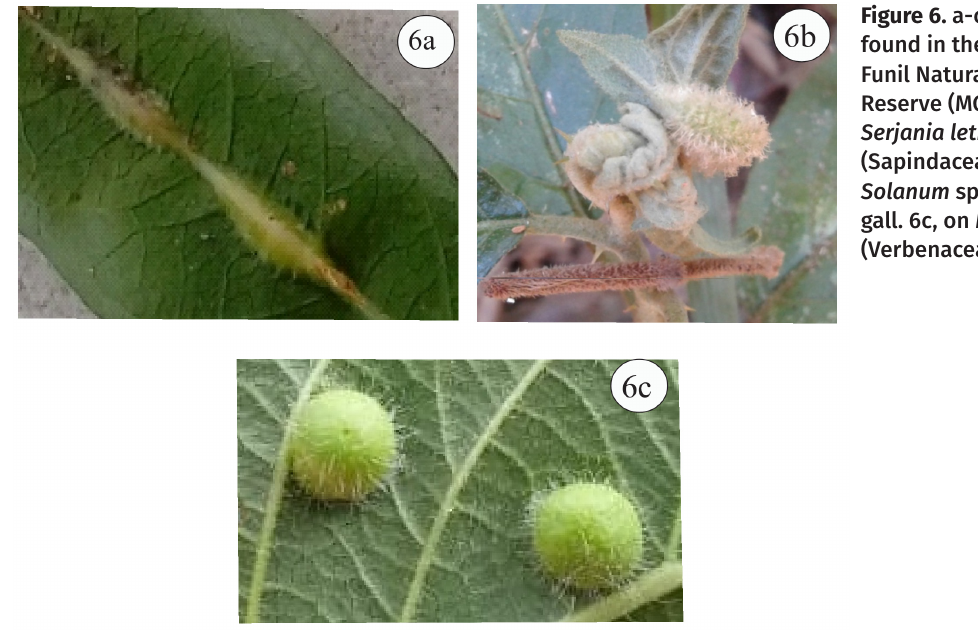
Figure 6. a-c. Insect galls found in the Serra Negra do Funil Natural Heritage